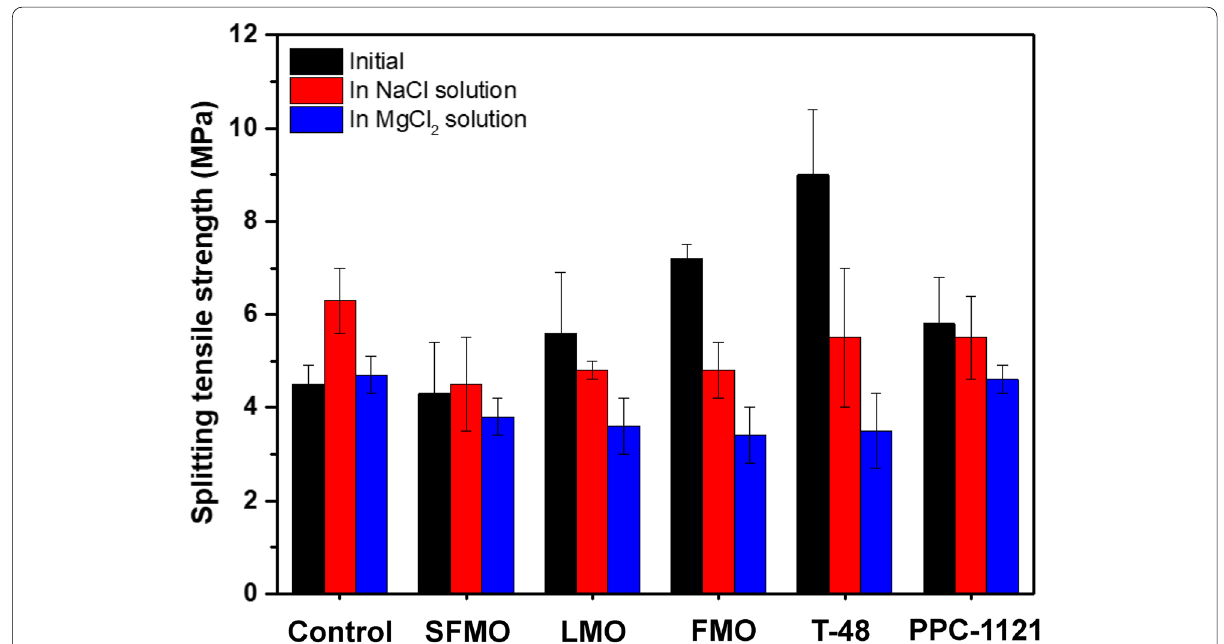
Fig. 3 Splitting tensile strength of concrete substrate incorporated with various overlays